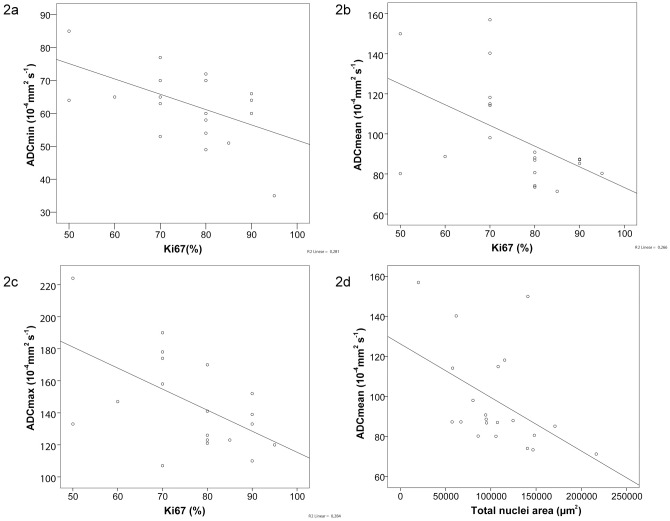
Significant correlations between ADC fractions (displayed as 10−4 mm2s-1) and histopathological parameters (Ki-67: positively stained nuclei displayed in % and total nuclei area: displayed in μm2).Statistical analysis documenting significant correlations between ADCmin and Ki-67 level (r = -0.454; p = 0.038) (a), ADCmean and Ki-67 level (r = -0.546; p = 0.010) (b), ADCmax and Ki-67 level (r = -0.515; p = 0.017). Significant correlations between ADCmean and total nuclei area (r = -0.500; p = 0.021) (d) are also shown.